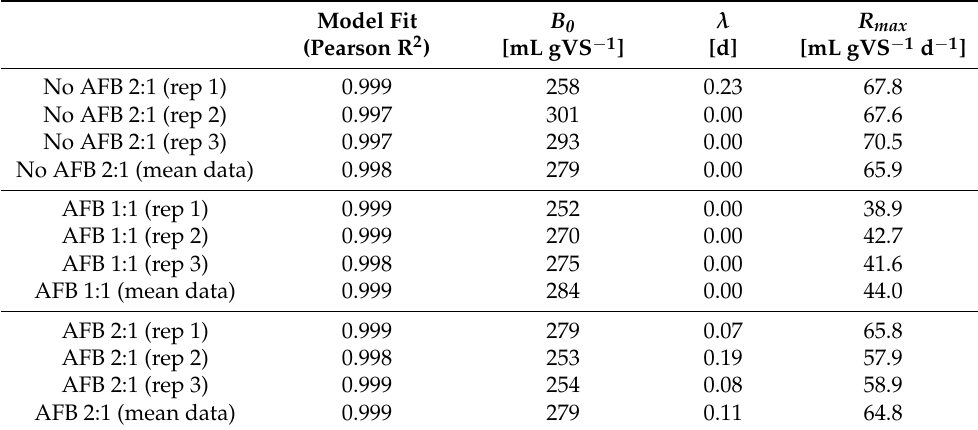
Table 3. Extracted Modified-Gompertz methane kinetic parameters for replicates and the mean methane yield data. Note that the mean data parameters were obtained by fitting to the mean yield curves rather than being means of the replicate model